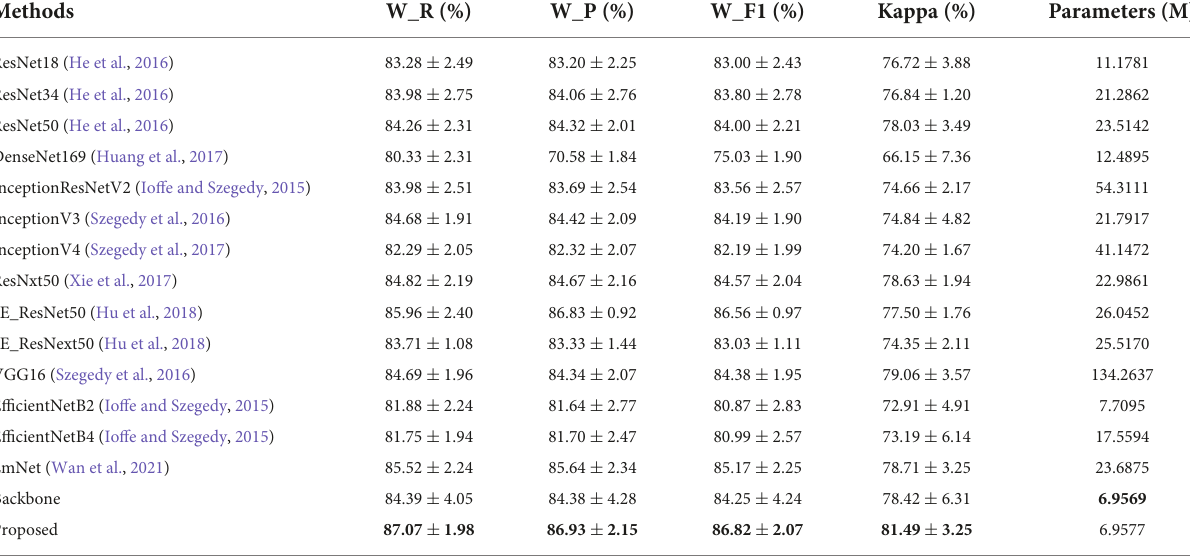
TABLE 2 The results of comparable experiments on general classification of corneal ulcers.